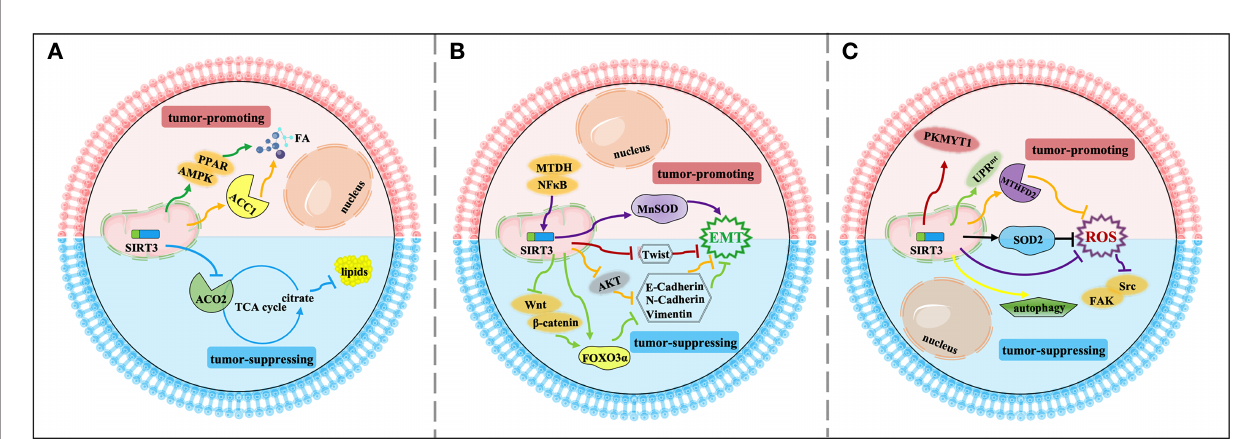
FIGURE 3 | Signaling functions of SIRT3 relevant to cancer metastasis. (A) SIRT3 regulates cancer metastasis by modulating tumor metabolism reprogramming. As a tumor-suppressing protein, SIRT3 deacetylates and inactivates ACO2 to inhibit adipogenesis and cancer metastasis. As a tumor-promoting protein, SIRT3 deacetylates and activates ACC1 and the AMPK/PPAR pathway to mediate FA synthesis and promote cancer metastasis. (B) SIRT3 regulates cancer metastasis by modulating EMT. As a tumor-suppressing protein, SIRT3 up-regulates Twist and inhibits EMT-related markers such as E-cadherin, N-cadherin, and N-cadherin by affecting FOXO3 a , AKT, and Wnt/ b -catenin/FOXO3 a pathway, thereby inhibiting EMT and cancer metastasis. As a tumor-promoting protein, SIRT3 regulates the NF k B/SIRT3/MnSOD pathway to promote EMT and cancer metastasis. (C) Other relevant mechanisms that SIRT3 participates in cancer metastasis. As a tumor-suppressing protein, SIRT3 regulates autophagy, and inhibits ROS production through SOD2 and the Src/FAK pathway, leading to suppression of cancer metastasis. As a tumor-promoting protein, SIRT3 deacetylates and regulates SOD2, MTHFD2, PKMYT1, and the SIRT3 axis of the UPR mt to promote cancer metastasis.